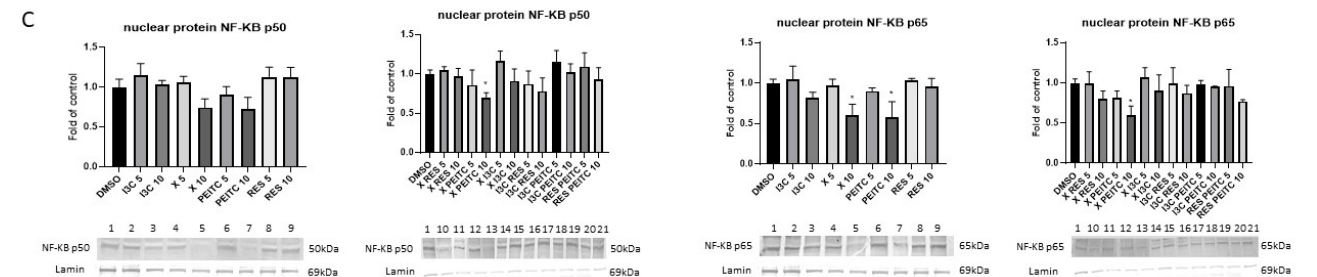
Figure 9. The impact of X, PEITC, RES, I3C, and their mixtures on NF- κ B activation and expression of its active subunits